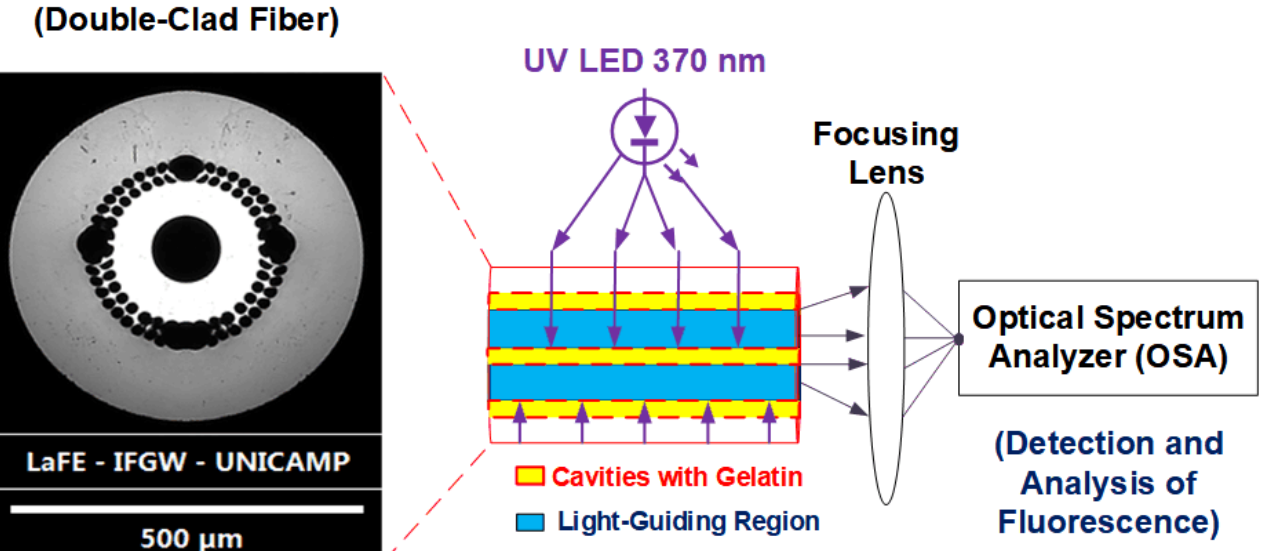
Figure 6. Setup for evaluation of the mPOF fluorescence and a micrograph of the fiber’s cross section.